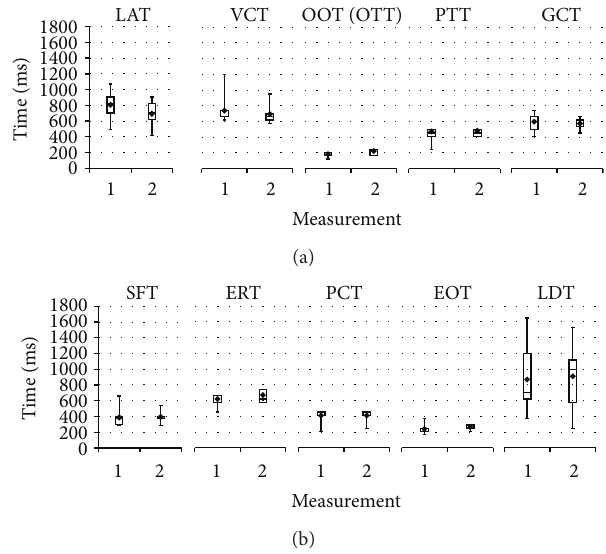
Figure 3: Durations of distinct swallowing events for two repetitive real-time MRI measurements (means and quartiles, 10 subjects). LAT: laryngeal ascent, VCT: velo-pharyngeal closure, OOT: oro- velar opening (start time defined as reference), OTT: oro-velar transit, PTT: pharyngeal transit, GCT: glottal closure, SFT: val- lecular and piriform sinus filling, ERT: epiglottic retroflexion, PCT: pharyngeal constriction, EOT: esophageal opening, and LDT: laryngeal